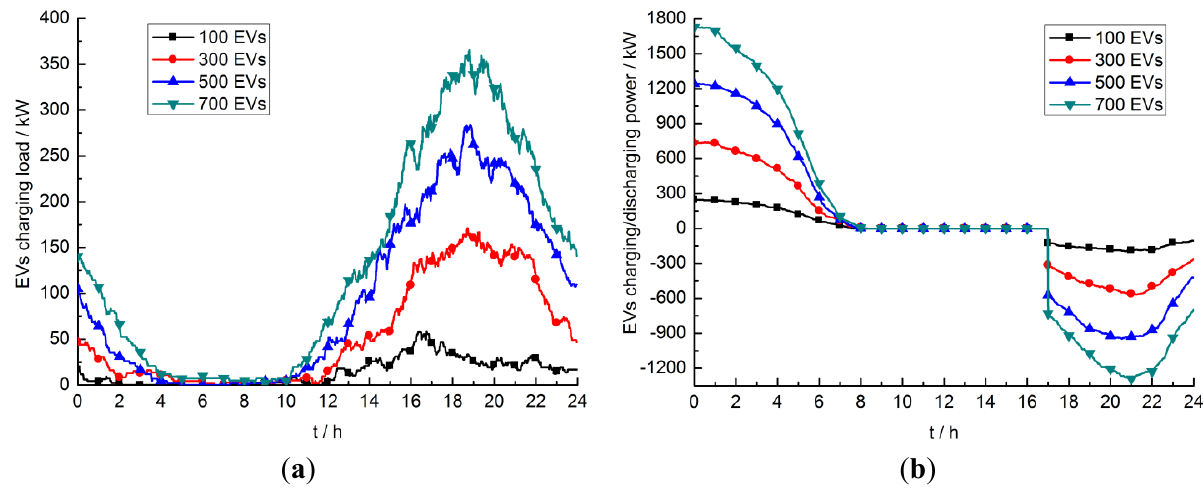
Figure 3. ( a ) The load profile of different numbers of EVs under autonomous charging mode; ( b ) The load profile of different numbers of EVs under coordinated charging/discharging mode.